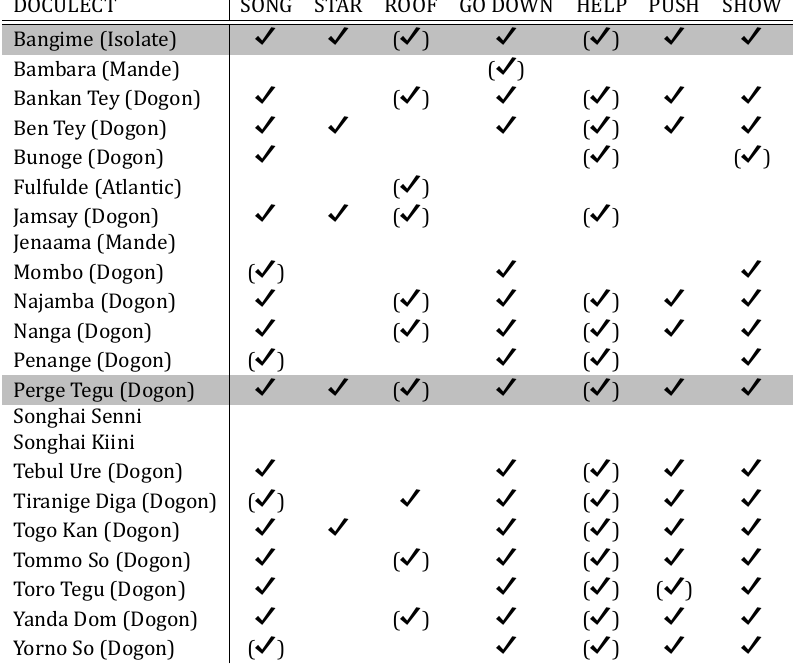
Table 10: Basic and cultural vocabulary items in Bangime shared predominantly with Dogon